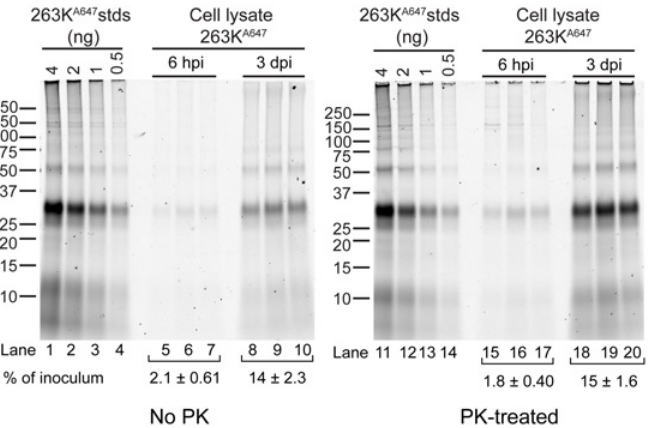
Fig 11. Biochemical characterization of internalized fluorescent aggregates in non-neuronal cells. Non-neuronal cells were treated with 263K A647 for the indicated times prior to lysis. No PK (lanes 5 – 10) samples correspond to 20% equivalents of cell lysates subjected to methanol precipitation. PK-treated (lanes 15 – 20) samples correspond to 70% equivalents of cell lysates subjected to PK digestion and PTA precipitation. Samples were analyzed by fluorescence SDS-PAGE. Lanes 1 – 4 and 11 – 14 contain dilution series of 263K A647 inocula that were processed identically to cell lysate samples but without application to the cells to serve as quantitation standards for input 263K A647 . Numbers (% of inoculum) represent mean amount of PrPres recovered at each time point as a percentage of the corresponding inoculum ± SD (n = 3).